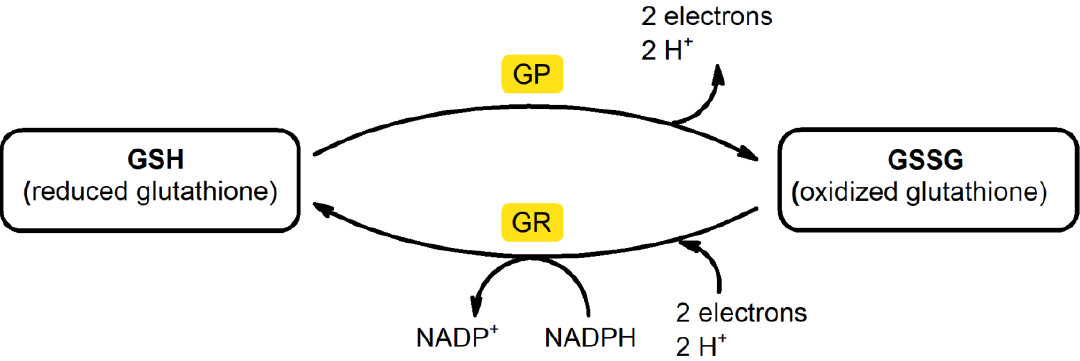
Figure 3. Glutathione exists in both the thiol-reduced (GSH) form and the disulfide-oxidized (GSSG) form. GSH:GSSG recycling is catalyzed by GSH peroxidase (GP) and GSH reductase form. GSH:GSSG recycling is catalyzed by GSH peroxidase (GP) and GSH reductase (GR).